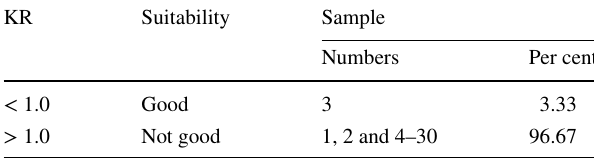
Table 12 Classification of KR for irrigation (Kelly 1963) KR